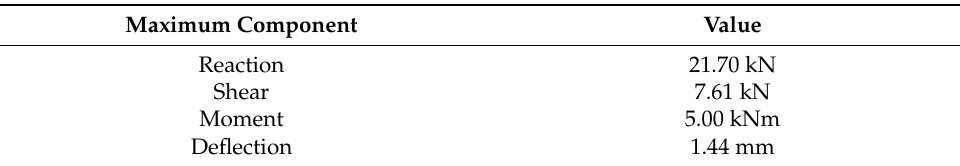
Table A2. Single-span beam load table for London, Ontario. Maximum Component